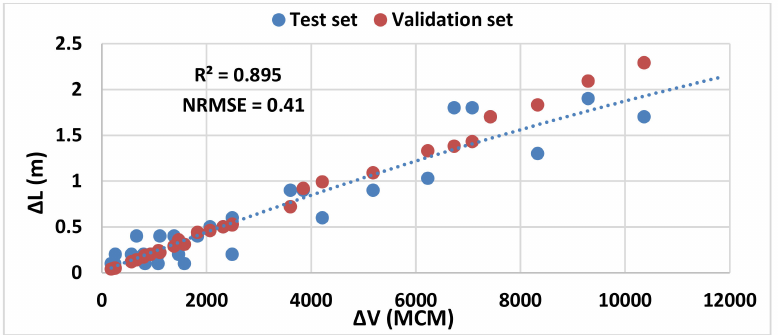
Figure 14. Relation between water level variation in meters and volume variation in MCM of